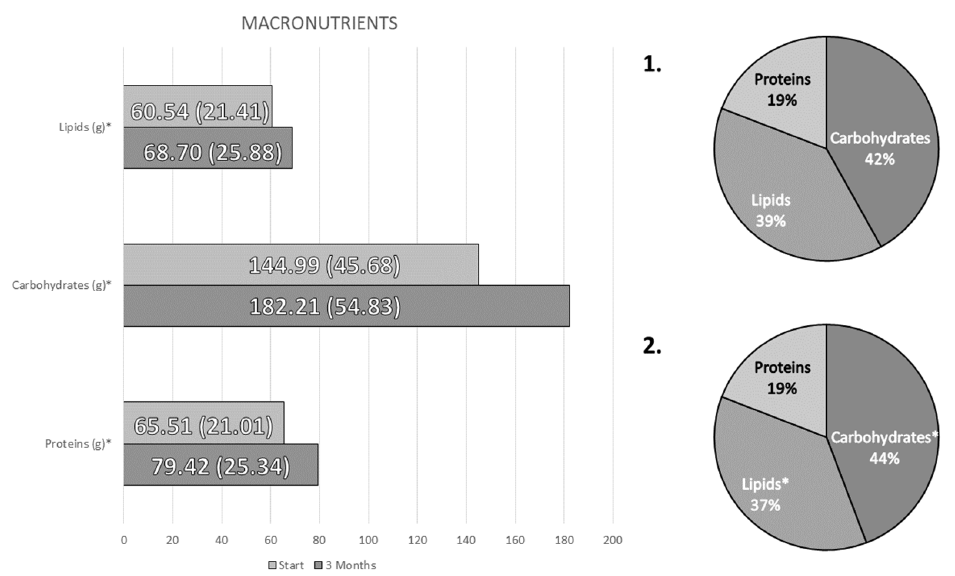
Figure 2. Differences in the consumption of macronutrients between the beginning of the intervention ( 1 ) and 3 months after it ( 2 ). * p -value < 0.05.